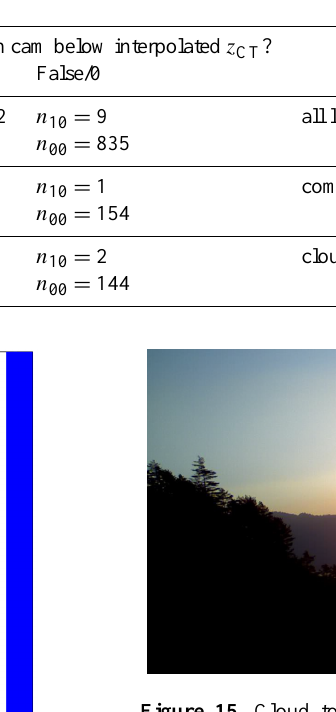
Table 1. Confusion matrices for the automated validation.